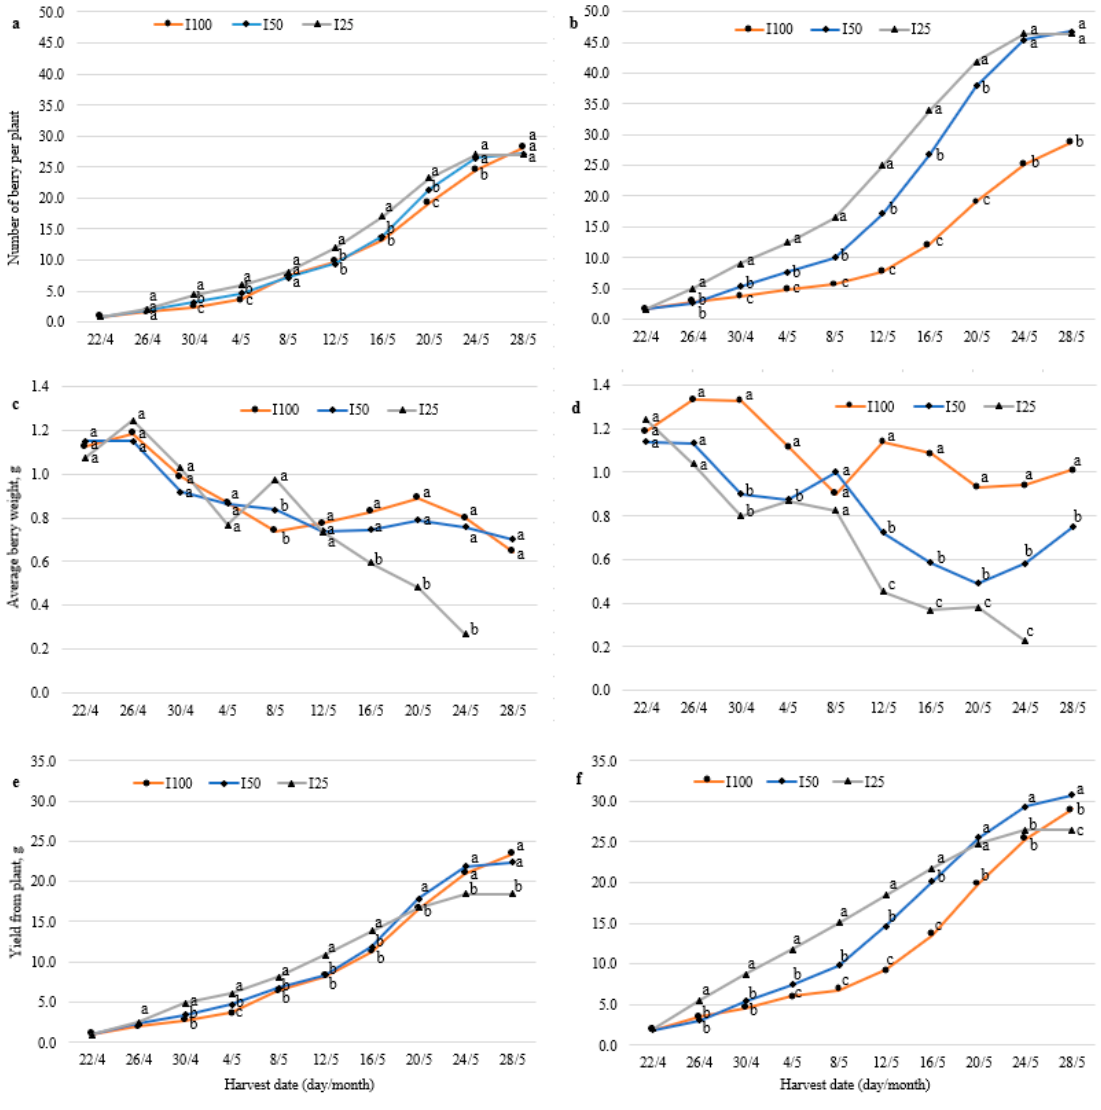
Figure 1. Cumulative berry number ( a , b ), average berry weight ( c , d ), and cumulative yield per plant ( e , f ) of alpine strawberry “Rojan” ( a , c , e ) and hybrid No. 17 ( b , d , f ) in different picks. Plants were fully irrigated (I100) and irrigated with half (I50) and a quarter (I25) of full irrigation. Data followed by the same letter are not significantly different according to the least significant difference (LSD) test at p ≤ 0.05.